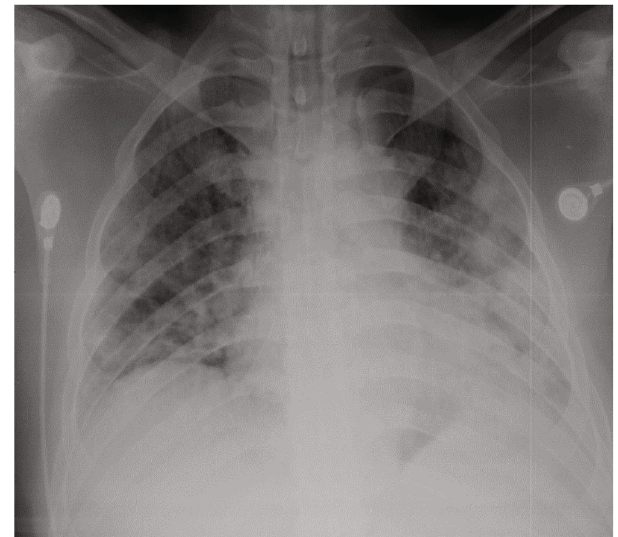
Figure 5: Chest radiograph of case 3 on day of the presentation with silent hypoxaemia showing widespread air space opaci fi cation in both lungs predominantly involving the lower